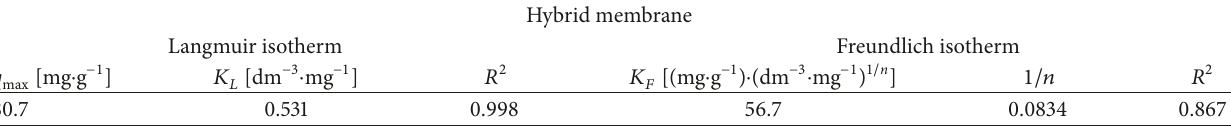
Table1:CoefficientofLangmuirandFreundlichisothermsforCr(VI)usinghybridmembraneofcarboxymethylchitosanandsilicondioxide. Hybrid membrane